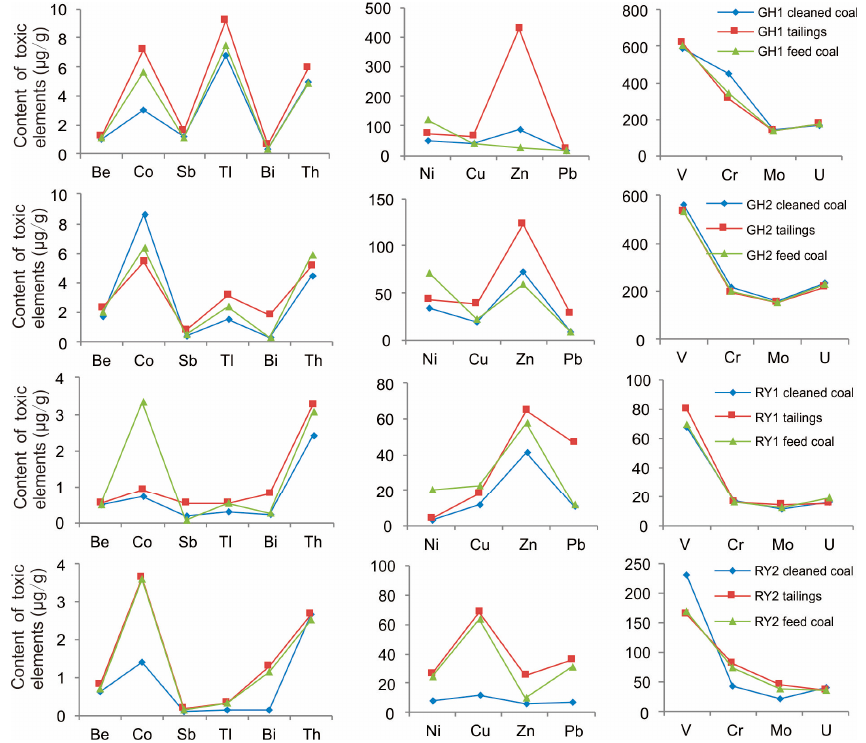
Figure 8. The contents of toxic elements in feed coal, cleaned coal, and tailings.